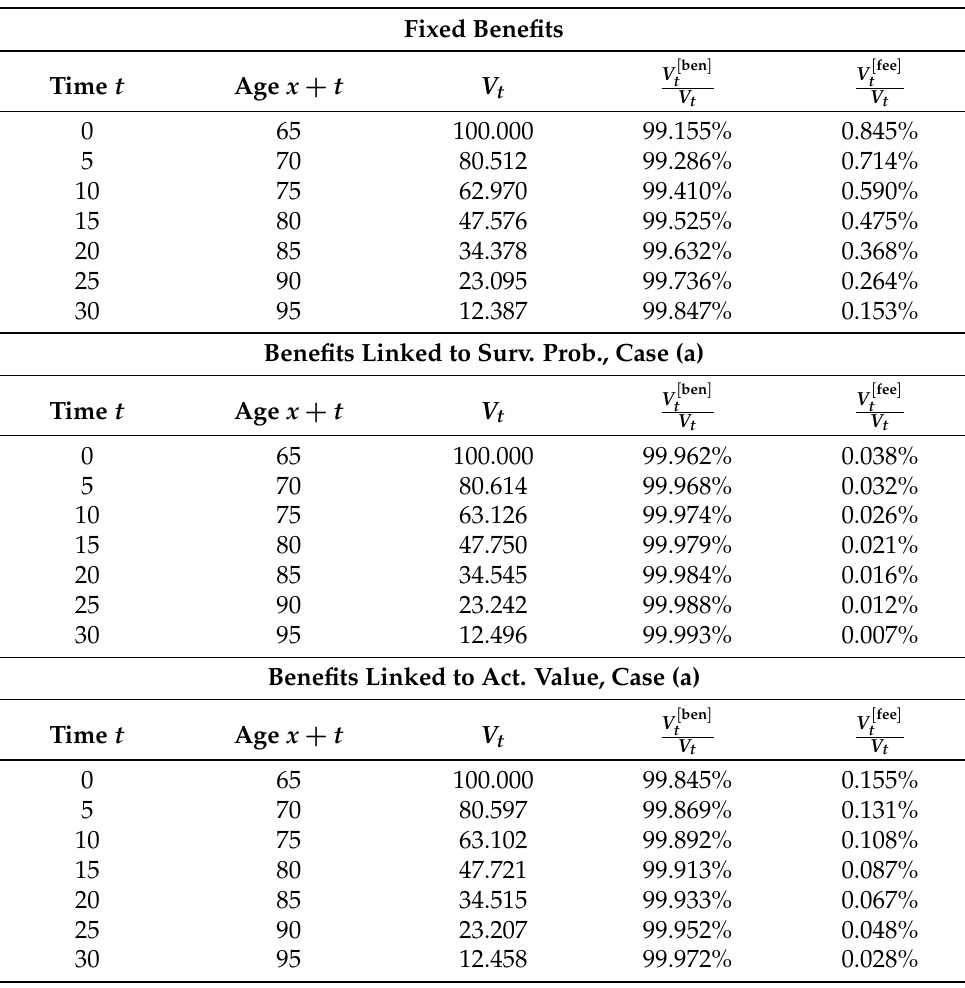
Table 5. Individual reserve V t and components V gate